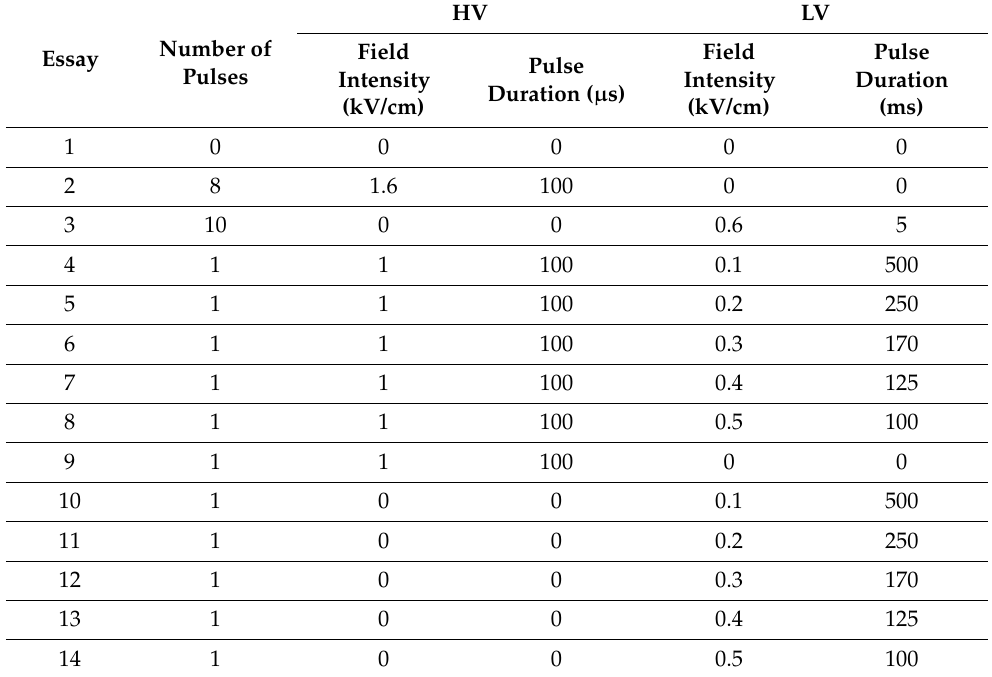
Table 1. HV-LV pulse parameters used in Figure